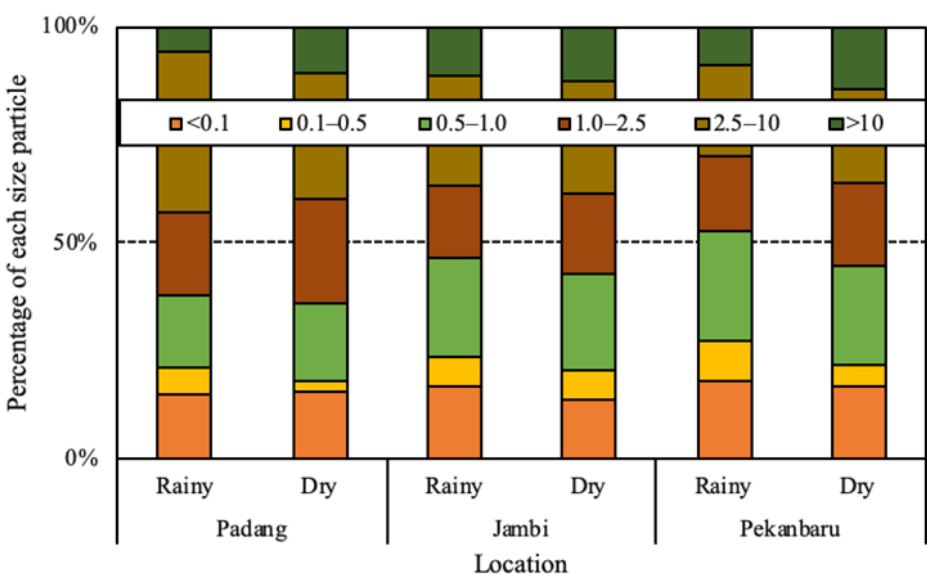
Figure 3. Particle size distribution observed at the study sites in Sumatra island.